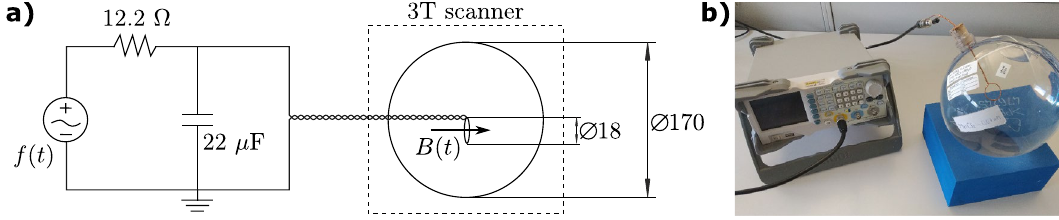
Figure 2. Diagram of the experimental setup. ( a ) A function generator is connected to a 12.2 Ω resistor in parallel with a 22 nF capacitor to avoid high-frequency coupling. The circuit is connected to a loop coil of isolated copper wire inside a plastic sphere filled with a solution of water and MnCl 2 (0.07 mmol). Diameter measures are in mm. ( b ) Picture of the phantom connected to the function generator outside the scanner